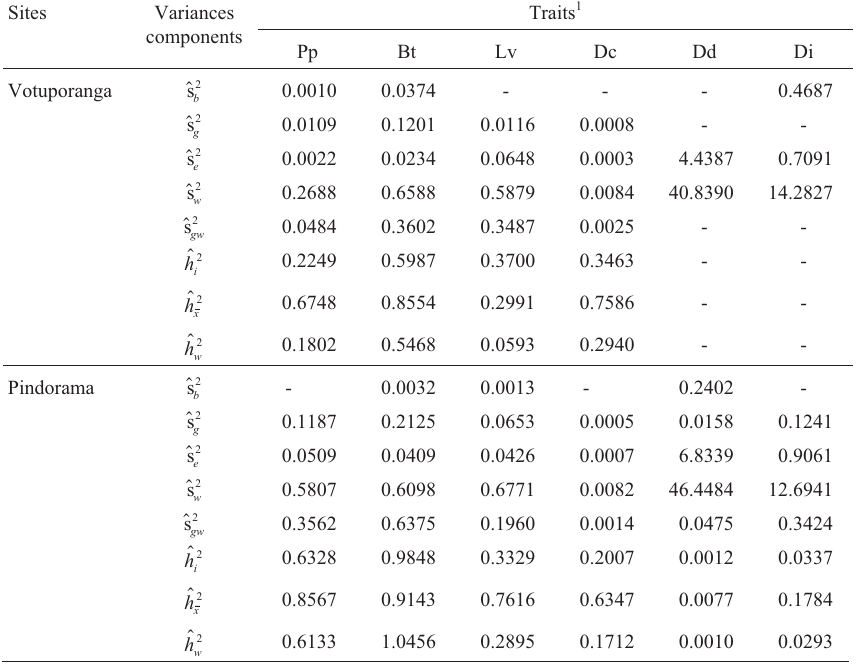
Table2 -Estimatesofvarianceduetoreplicationwithinsites( (cid:1) s 2 ), phenotypic variance within progenies ( (cid:1) s ( (cid:1) s e (cid:1) 2 ), among progeny means ( plants ( h i progenies growing at three sites in the Brazilian State of São